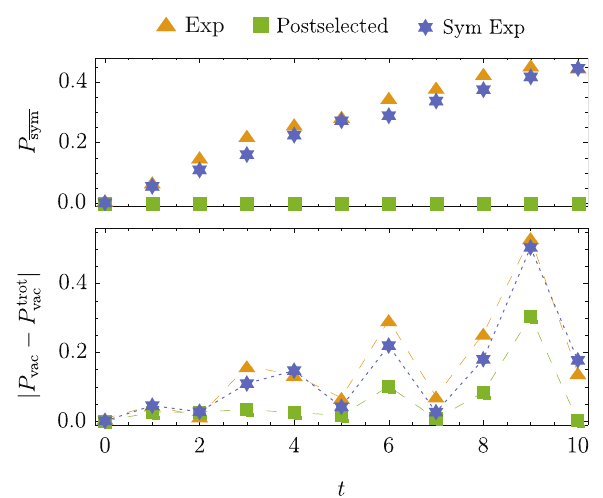
FIG. 9. The leakage to the symmetry-forbidden subspace (upper panel) and deviation of the experimental results from the- ory for the bare-vacuum population (lower panel) when different schemes to mitigate errors are applied: no mitigation (orange tri- angles), postselection (green squares), and symmetry protection (blue stars). Note that by definition, the leakage to the symmetry- forbidden subspace is zero after postselection. In both plots, N = 4 and δ t = 1.0, the system is initiated in the bare-vacuum state and is evolved via the odd-even ordering scheme. Sym Exp refers to the experimental results with symmetry